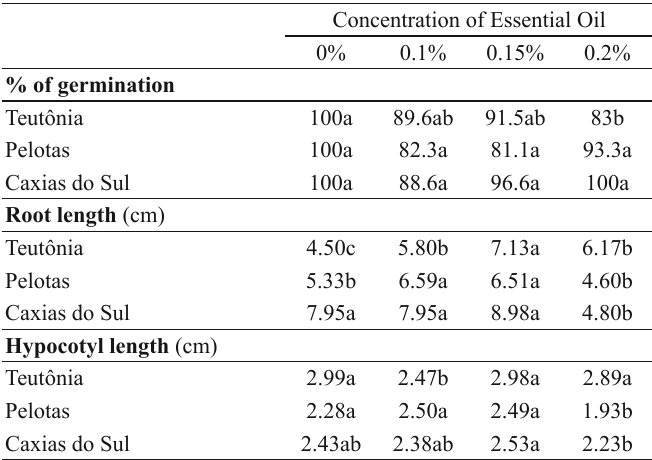
Effect of different concentrations of three chemotypes of Lippia alba essential oils on the germination and growth of tomato seeds. (Teutônia – citral chemotype, Pelotas – camphor/1,8-cineole chemotype, Caxias do Sul – linalool chemotype).